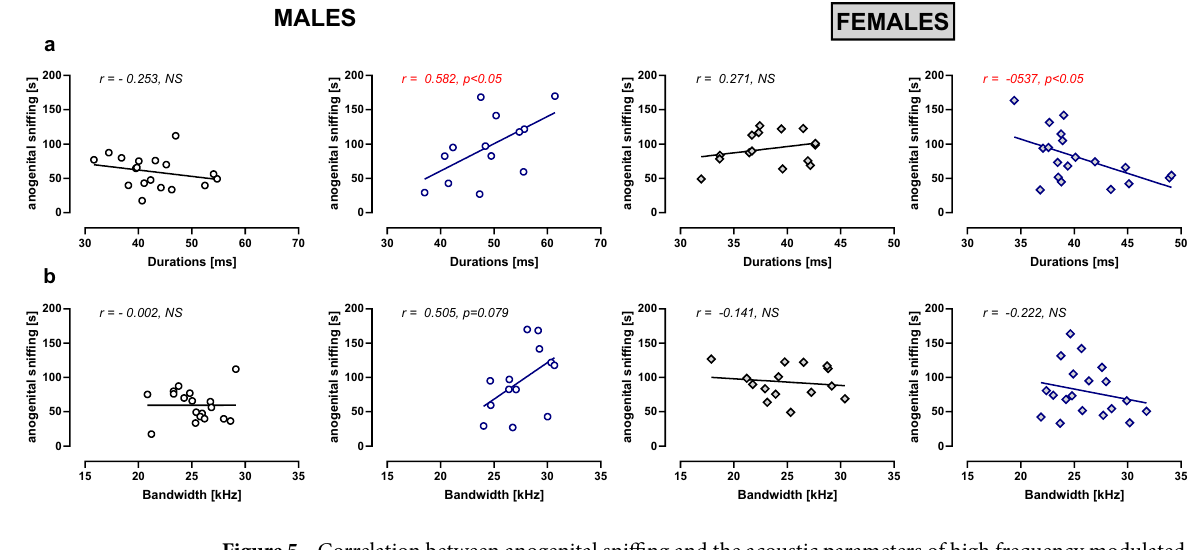
Figure 5. Correlation between anogenital sniffing and the acoustic parameters of high frequency modulated (HFM) USVs. A Pearson correlation coefficient (r) was calculated for the relationship between the time spent on anogenital sniffing and the duration (a) and bandwidth (b) of HFM calls.